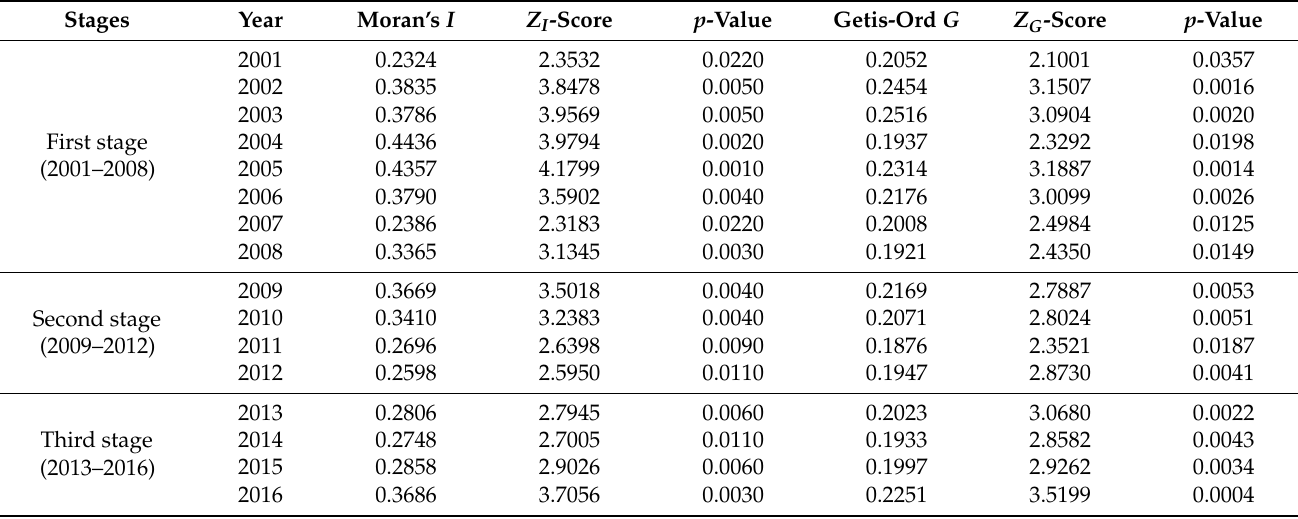
Table 3. Spatial autocorrelation indexes of land finance from 2001 to